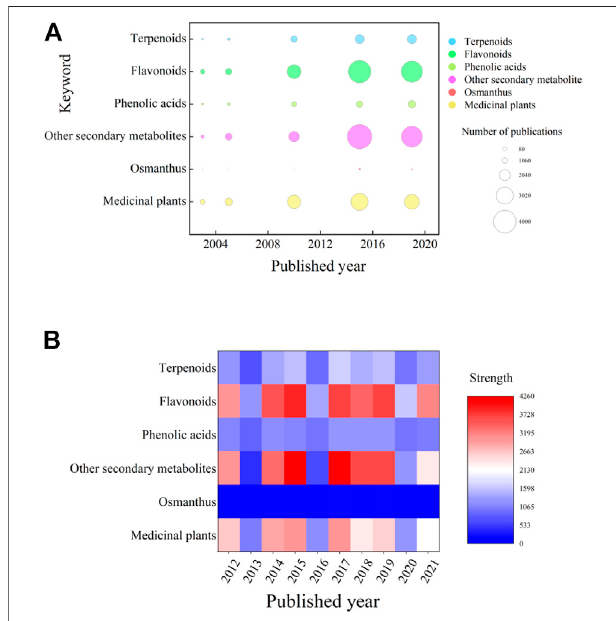
FIGURE1| Summaryoftheliteratureaccordingtokeyworkandtheyear published over the last 10 years. (A) Bubble chart showing the number of publications in 5 years from the past 10 years. The horizontal axis is the publication year, and the vertical axis is the relevant keyword used to search the literature. Correlative studies are relatively weak, and studies of varioussecondarymetabolitesareclearlydifferentiated. (B) Heatmapshowing the prevalence of keywords in publications over the past 10 years. The fi gure shows that the research statuses of the three major categories of secondary metabolites selected in this paper are very different, with research on fl avonoids being the most extensive and research on phenolic acids being the least extensive. (The basic principle of the author ’ s preliminary background investigation before writing this manuscript isto fi rst conduct ageneral search on the research progress of O. fragrans , select compounds extracted from O. fragrans ,and thenscreenoutrelativelyimportant secondary metabolites of O. fragrans